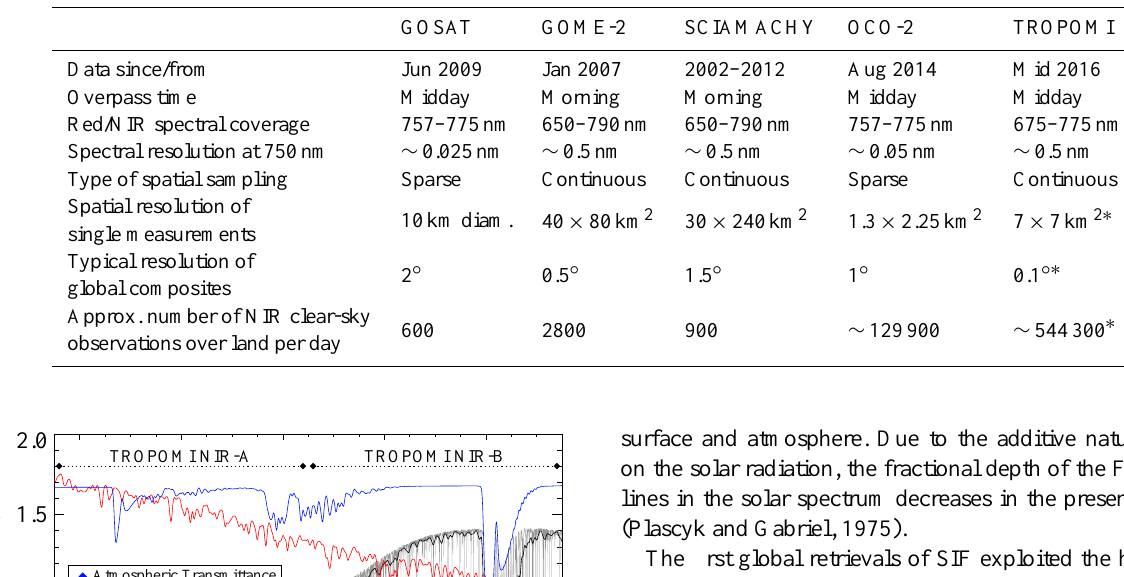
Table 1. Relevant characteristics of current and near-future satellite missions enabling SIF retrievals. The improvement in spatial resolution and number of clear-sky observations per day from Sentinel-5 Precursor/TROPOMI are highlighted with ∗ . NIR stands for near-infrared. It must be noted that GOME-2 on MetOp-A has been operating in a reduced-swath mode since 15 July 2013 with a reduced pixel size of 40 × 40km 2 .